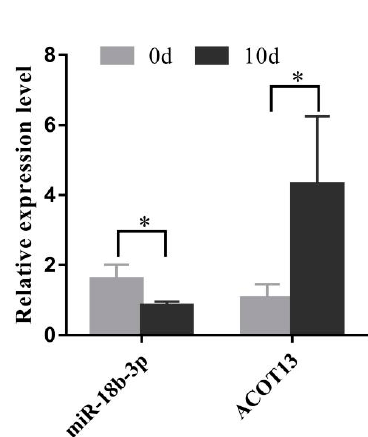
Figure 4. The ACOT13 gene was a potential target gene of miR-18-3p. ( A ) Cluster analysis showed miR-18b-3p was conserved in various species. ( B ) Conservatism analysis of the miR-18b-3p seed region. ( C ) The interaction of miR-18b-3p and ACOT13 was predicted based on miRCat. ( D ) Expression of miR-18b-3p and ACOT13 in pre-di ff erentiation (0 day) and post-di ff erentiation (10